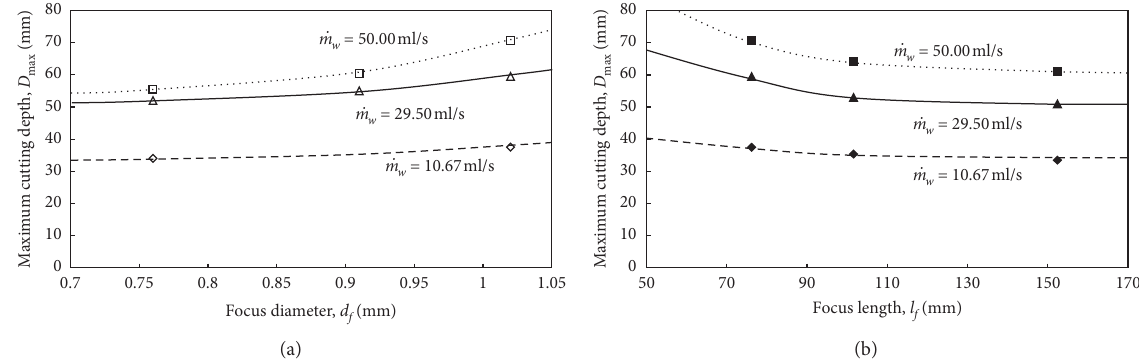
Figure 9: Relation between the focus geometry and the maximum cutting depth at an SOD of 10mm: (a) focus diameter; (b) focus length.